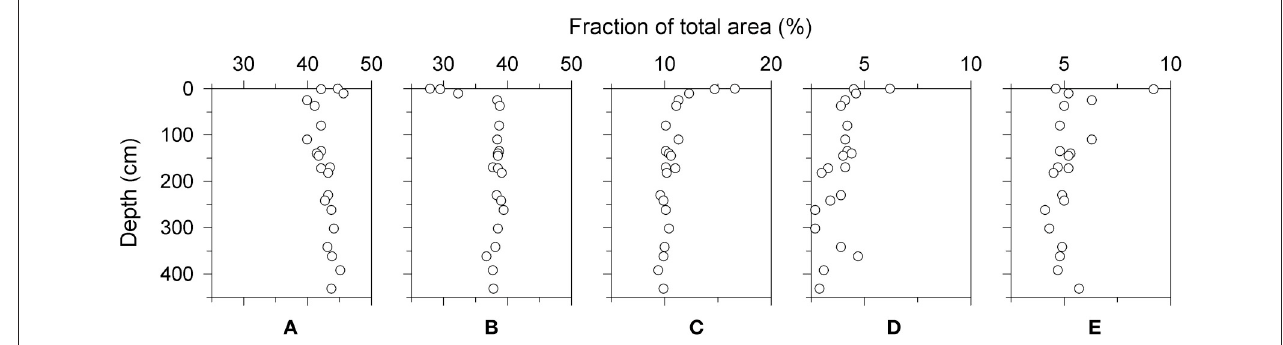
FIGURE 3 | Depth variability in the fraction of total area attributed to major 1 H types: (A) aliphatic, 0.2–1.9 ppm; (B) functionalized, 1.9–3.1 ppm; (C) H CO (band N in Table 2 ), 3.1–4.1 ppm; (D) olefinic (band O in Table 2 ), 4.9–7.0 ppm; (E) aromatic, (band P in Table 2 ), 7.0–10.0 ppm. Total area under each section of the spectrum is shown (sum of peaks and area under unresolved envelope). Substructure assignments are based on Hertkorn et al. (2013) and shown in Table 1 . δ H 4.1–4.9 ppm (where the solvent peak appears) was excluded. Only the data obtained on the 400 MHz spectrometer are